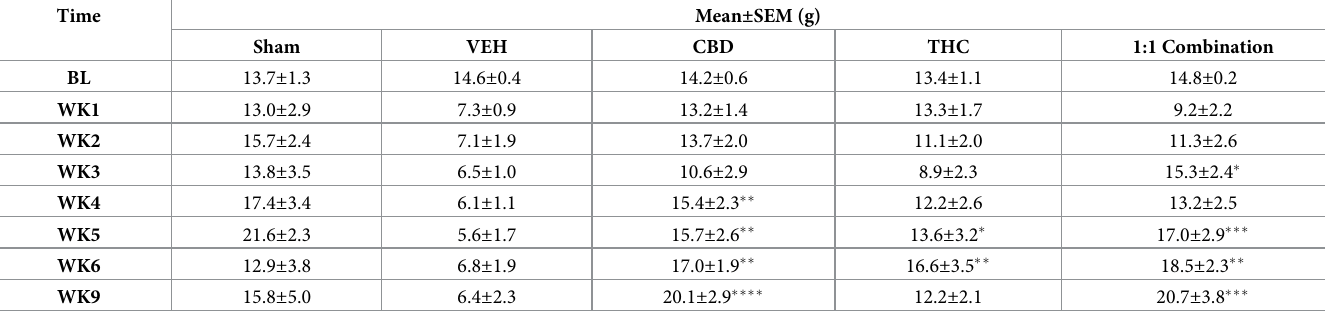
Table 3. Male von Frey behavioural data presented as the mean withdrawal force, in grams (g).